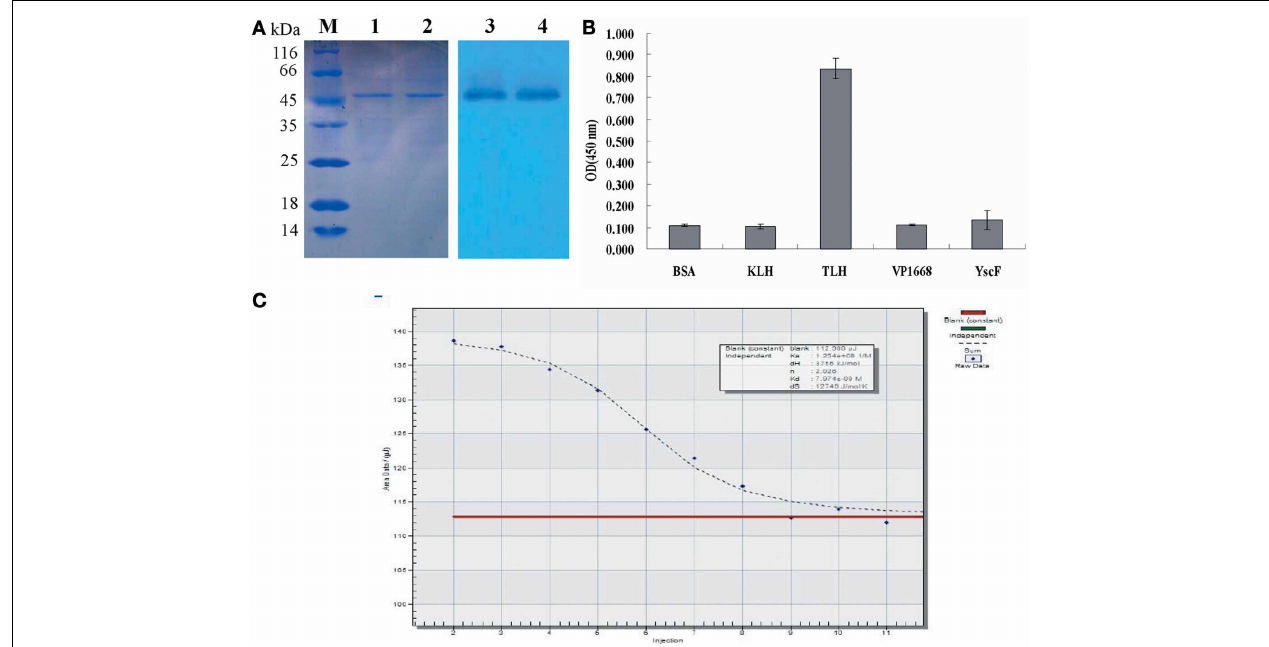
96-well plates in triplicate (5 μ g/mL, 100 μ L/well). The purified scFv were added to the reaction wells and incubated for 2h at 37 ◦ C. Specificity of Skp co-expressed scFv was determined using an anti-6 × His tag antibody. (C) Affinity Determination of Skp co-expressed scFv. The affinity of anti-TLH Skp co-expressed scFv for the TLH antigen was studied by Microcalorimetry using the Nano ITC-LV. The measured data was used for